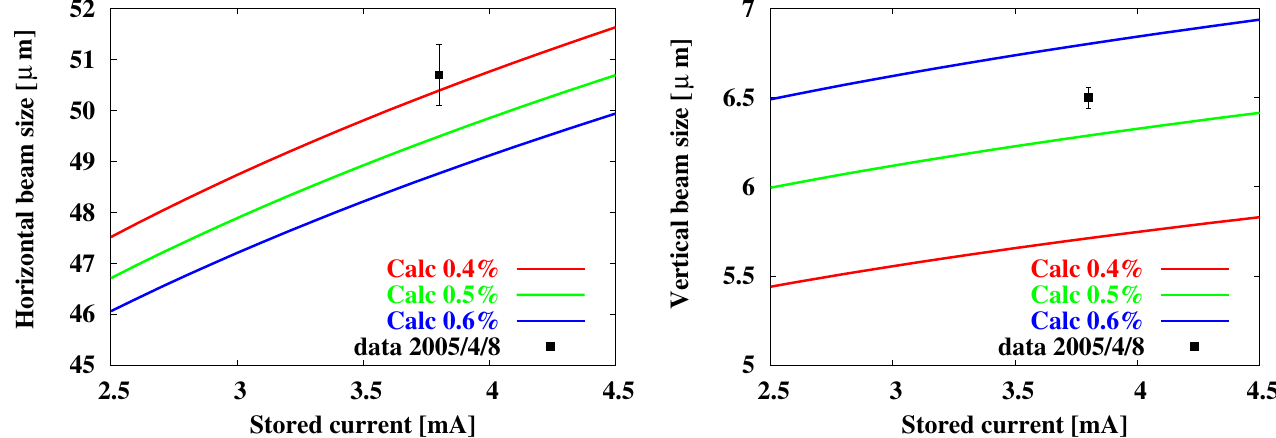
FIG. 16. (Color) Measured beam size taken on 2005 = 4 = 8 by the FZP monitor vs beam current in the single-bunch mode. The lines are from a calculation with intrabeam scattering, assuming coupling ratios of 0 : 4% , 0 : 5% , and 0 : 6%